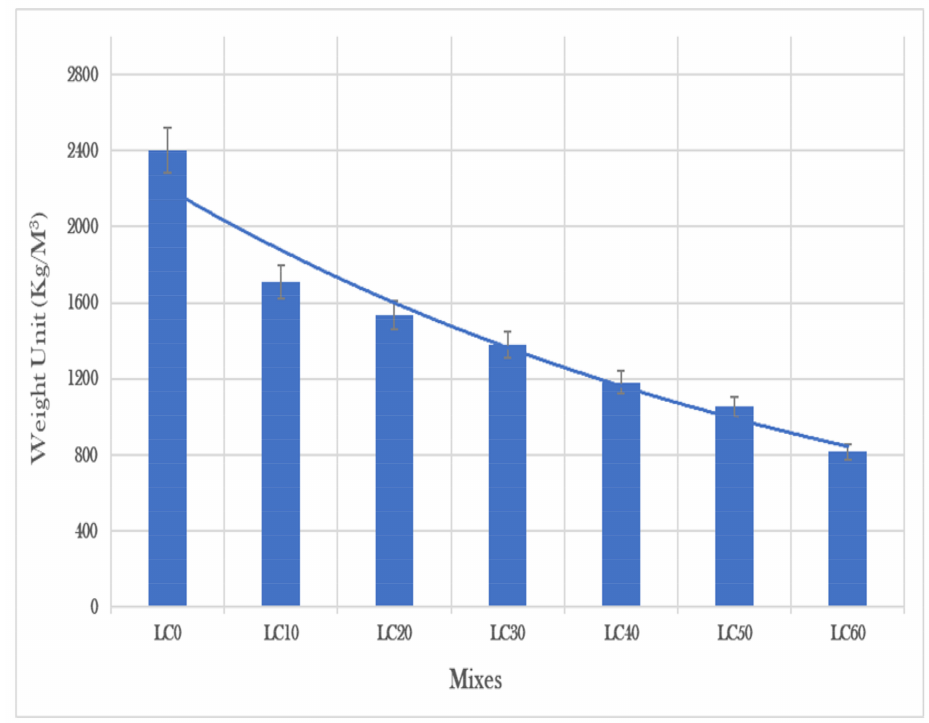
Figure 7. Effect of EPA aggregate dosage on the unit weight of concrete specimens.